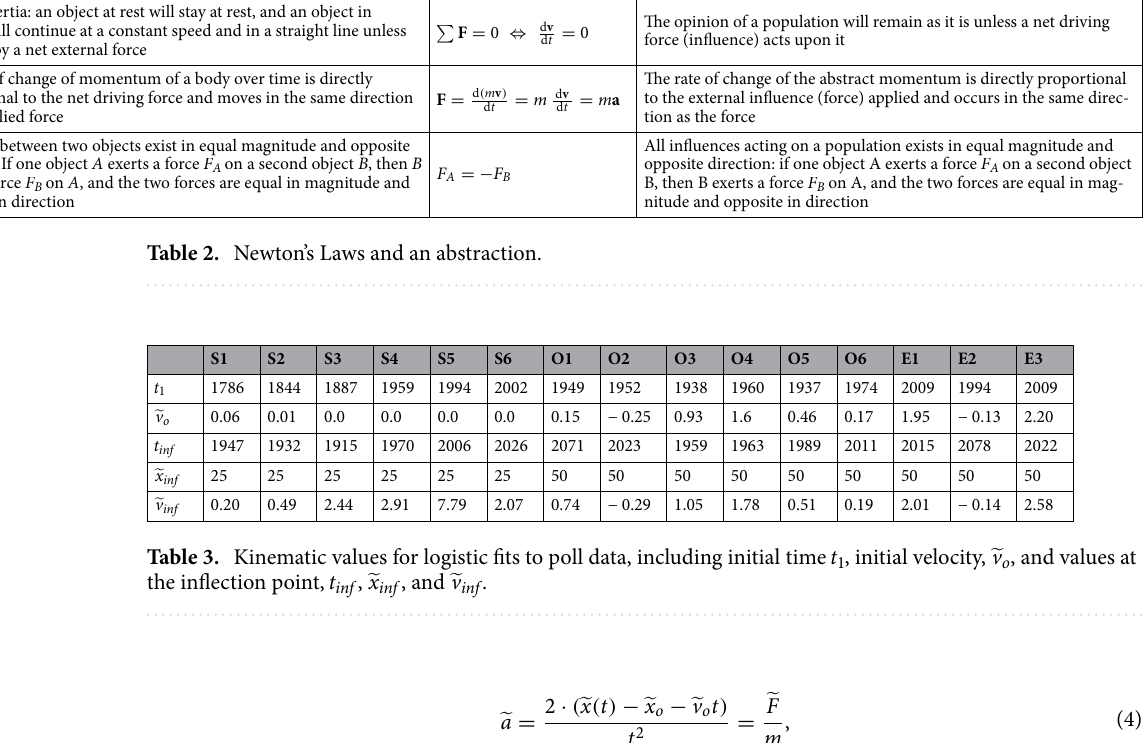
Fig. 1 using logistic fits for each poll. The time t , or year, is marked at the inflection point of the logistic curve. This is shown in Figs. 2 and 3 for years 1915 and 2005 respectively. Acceleration is determined at the inflection point and time t is measured from the first poll data point t 1 to the inflection point t inf , or t = t inf − t 1 . Likewise, the position, (cid:31) x ( t ) represents the “distance” along the y-axis in Figs. 2 and 3, measured from the first data point to the inflection point, or (cid:31) x ( t ) = (cid:31) x ( t inf ) − (cid:31) x ( t 1 ) . The initial velocity (cid:31) v o , is determined using the values of the fitted curve at the first two data points or,